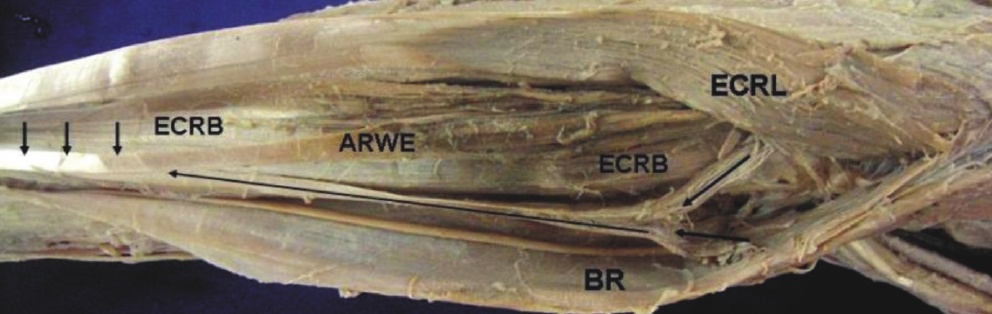
Figure 3b - Superior-lateral view of the right forearm region. ARWE, additional radial wrist extensor. The downward arrows indicate its course, already shown in figure 3a. BR, brachioradialis. Note the additional muscles arising both from the BR (lateral) and ECRL (medial), joining to form a single muscle on its way to be inserted into the tendon of the